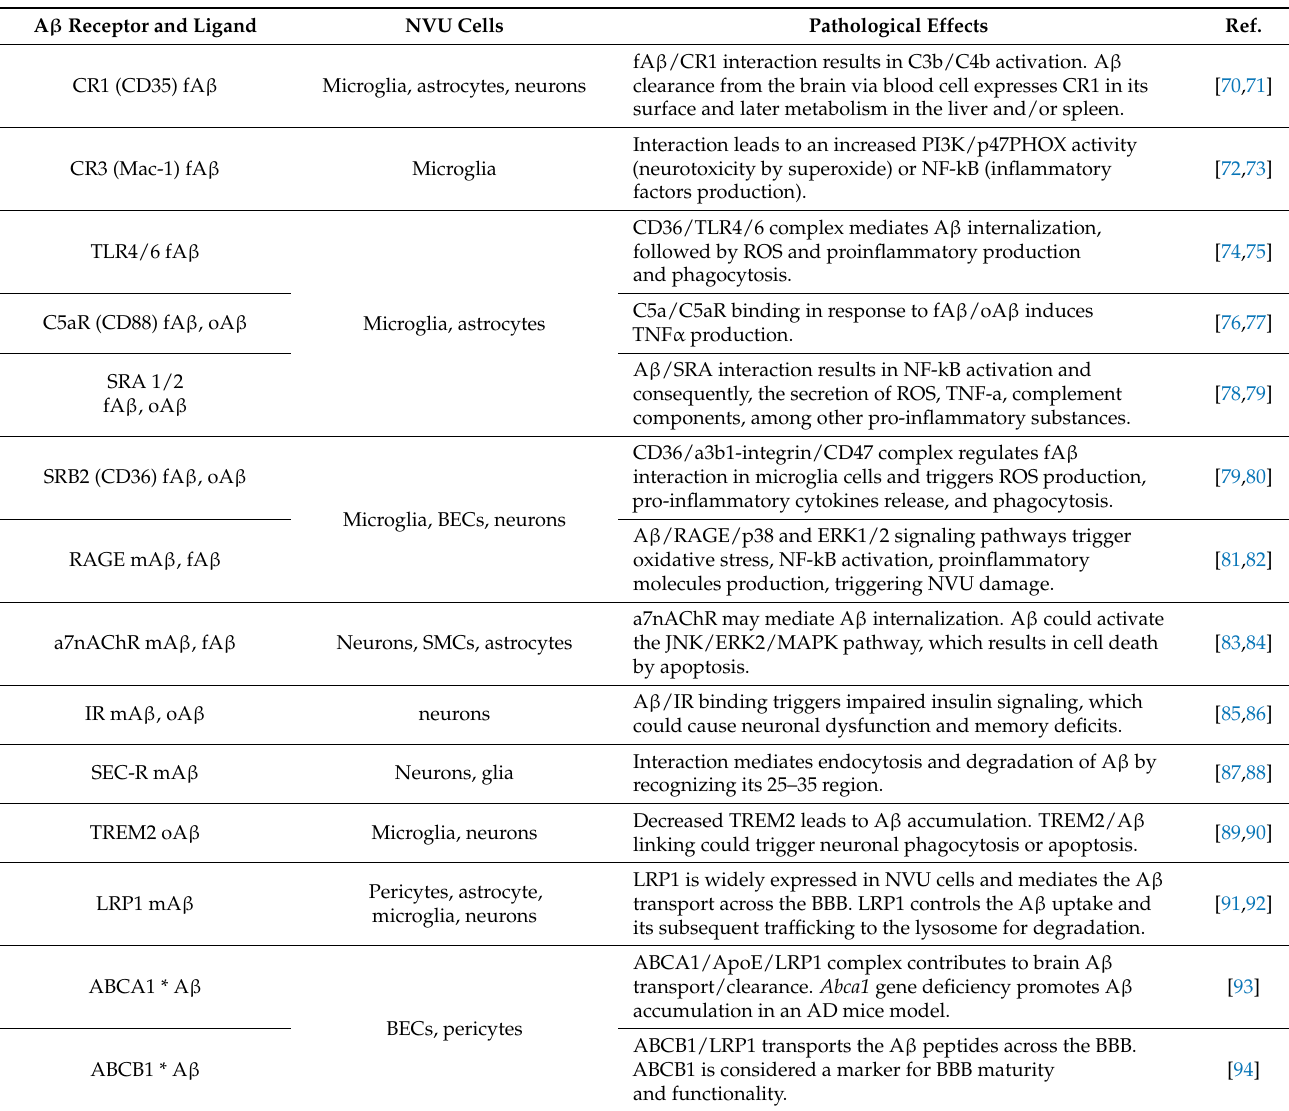
Table 1. Interaction among different species of A β aggregates (f: fibrillar; o: oligomeric; m: monomeric; *: unknown), receptors in NVU cells, and pathological